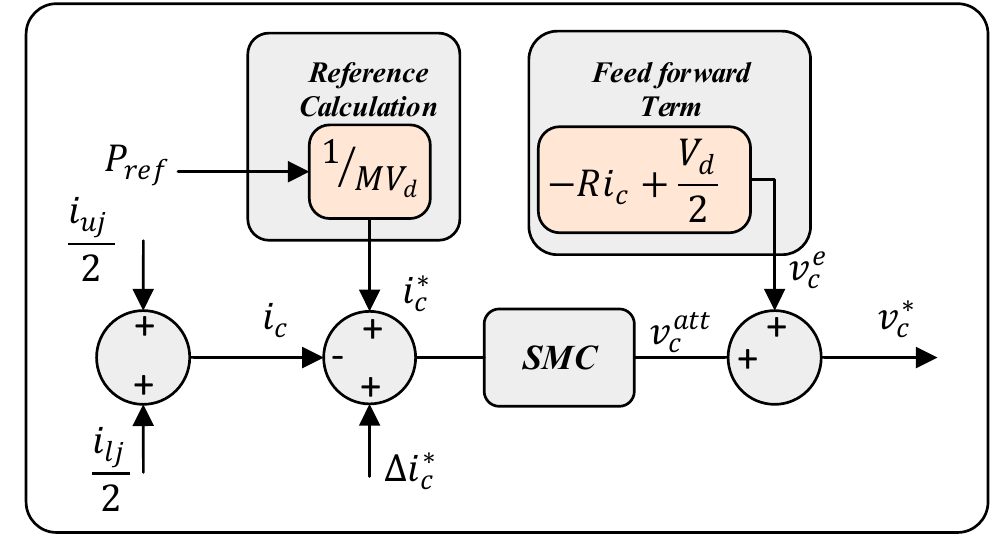
Figure 6. Current control structure .